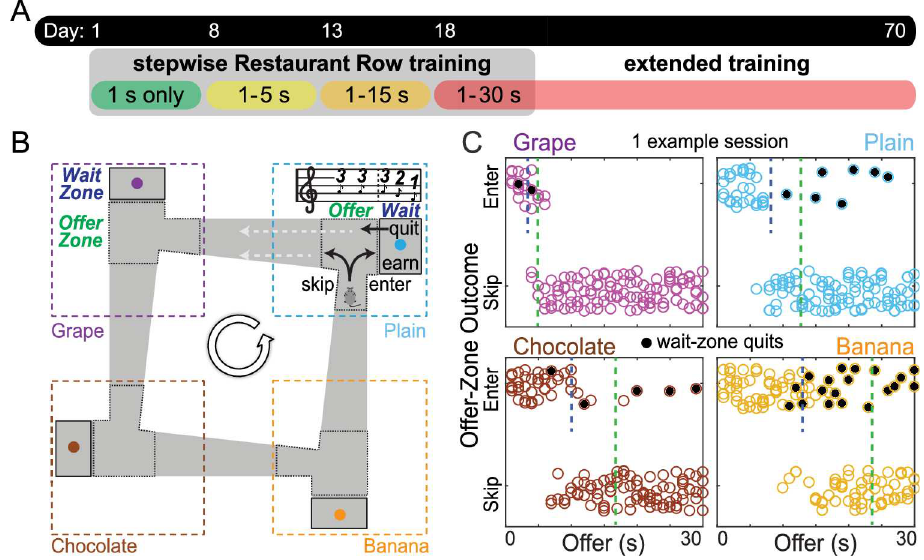
Fig 1. Longitudinal economic design of the Restaurant Row task. (A) Experimental timeline. Mice were trained for 70 consecutive d, earning their only source of food on this task. Stages of training were broken up into blocks in which the range of possible offers began in a reward-rich environment (all offers were always 1 s, green epoch) and escalated to increasingly reward-scarce environments (offer ranges of 1–5 s, 1–15 s, 1–30 s). (B) Task schematic. Food-restricted mice were trained to encounter serial offers for flavored rewards in 4 “restaurants.” Restaurant flavor and location were fixed and signaled via contextual cues. Each restaurant contained a separate offer zone and wait zone. Tones sounded in the offer zone; fixed tone pitch indicated delay (randomly selected from that block’s offer range) mice would have to wait in the wait zone. Tone pitch descended during delay “countdown” if mice chose to enter the wait zone. Mice could quit the wait zone for the next restaurant during the countdown, terminating the trial. Mice were tested daily for 60 min. (C) Example session (from the 1–30 s red epoch) with individual trials plotted as dots. This representative mouse entered low delays and skipped high delays in the offer zone while sometimes quitting once in the wait zone (black dots). Dashed vertical lines represent calculated offer zone (green) and wait zone (blue) “thresholds” of willingness to budget time. Thresholds were measured from the inflection point of fitting a sigmoid curve to enters versus skips or earns versus quits as a function of delay cost. Data available as a supplemental file.